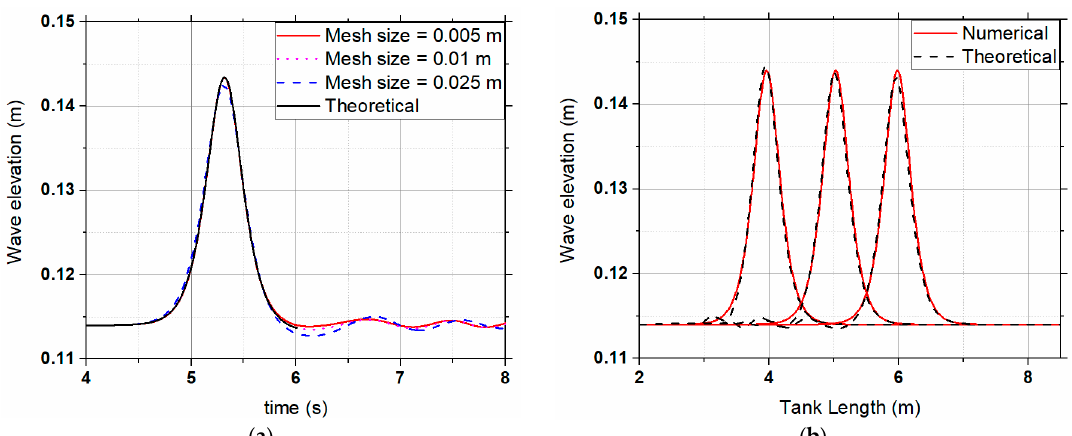
Figure 2. ( a ) Comparison of wave elevation (H = 0.03 m) at x = 5.62 for Δ x = 0.025, 0.01 and 0.005 m with theoretical solitary wave profile ( b ) Comparison between the numerical and the theoretical wave profile along the NWT when the crest reaches x1, x2 and